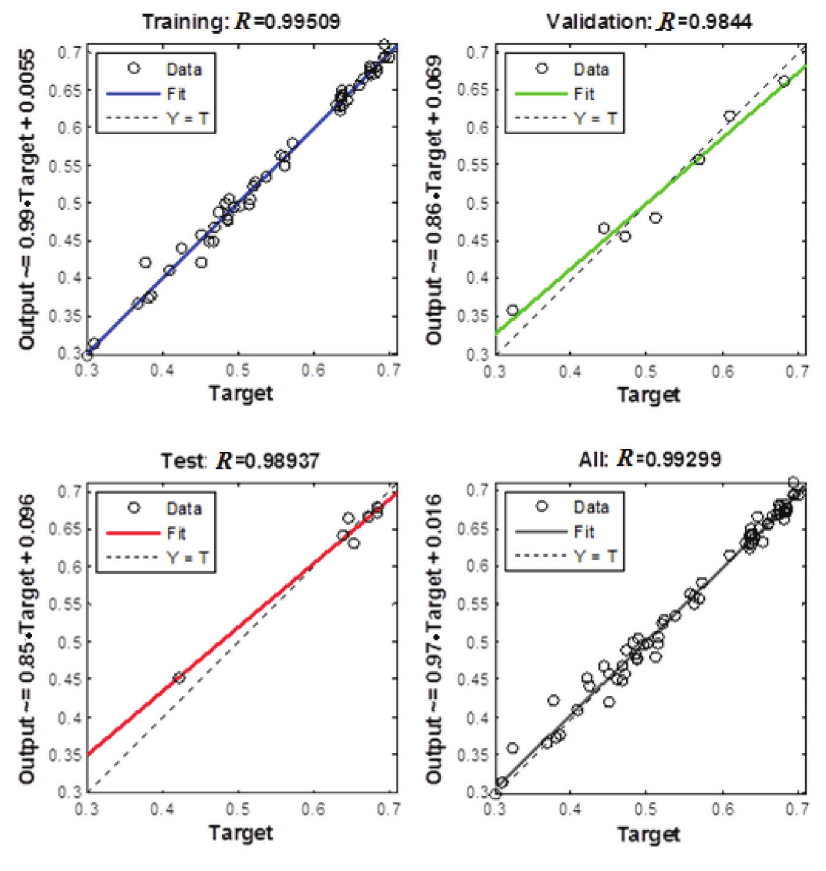
Fig. 7 – ANN model showing the regression plots for training, validation, testing, and overall prediction